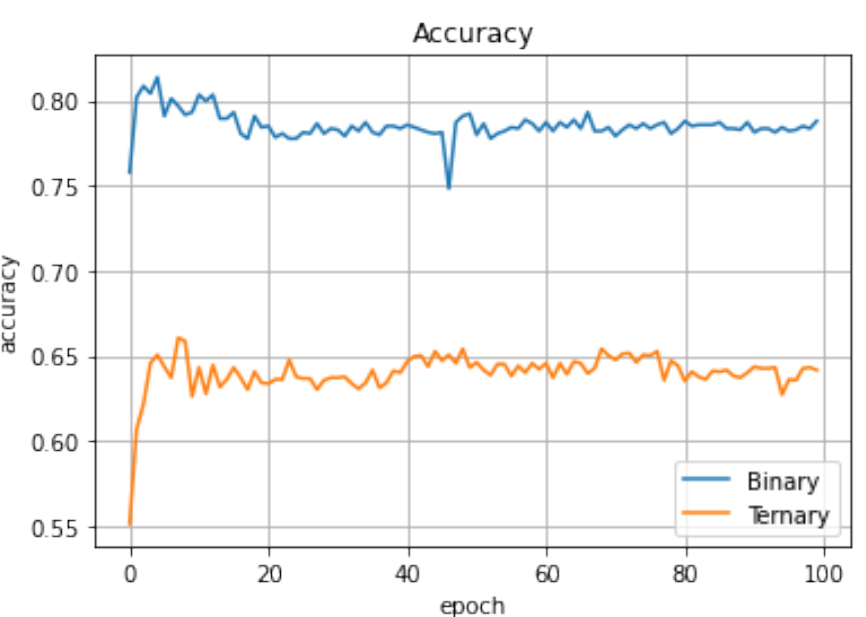
Figure 5. Validation accuracy comparison of binary and ternary classification on the RUECD